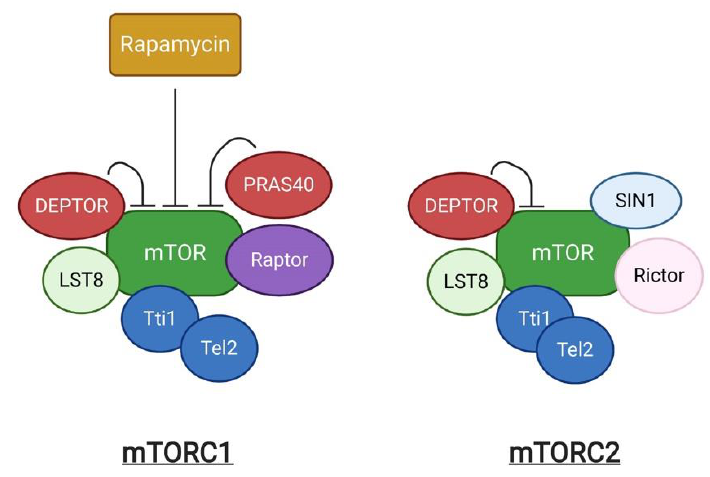
Figure 1. A schematic representation of mTOR complexes.